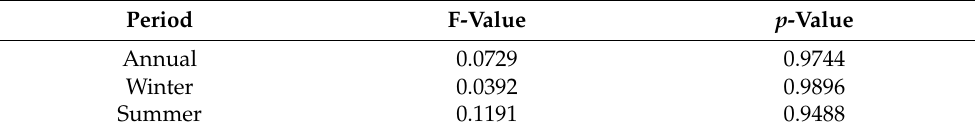
Table 6. Summary of the output ANOVA and Tukey–Kramer tests for future extreme Hs